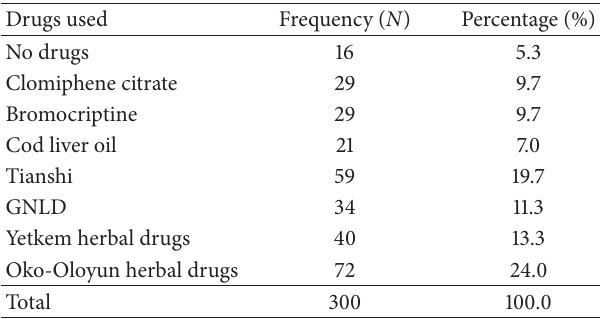
Table 3: Knowledge of fibroids.